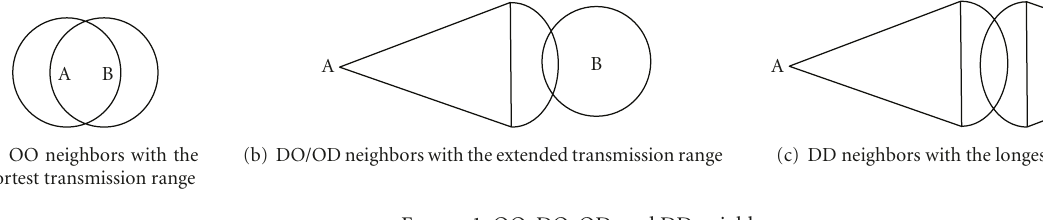
Figure 1: OO, DO, OD, and DD neighbors.